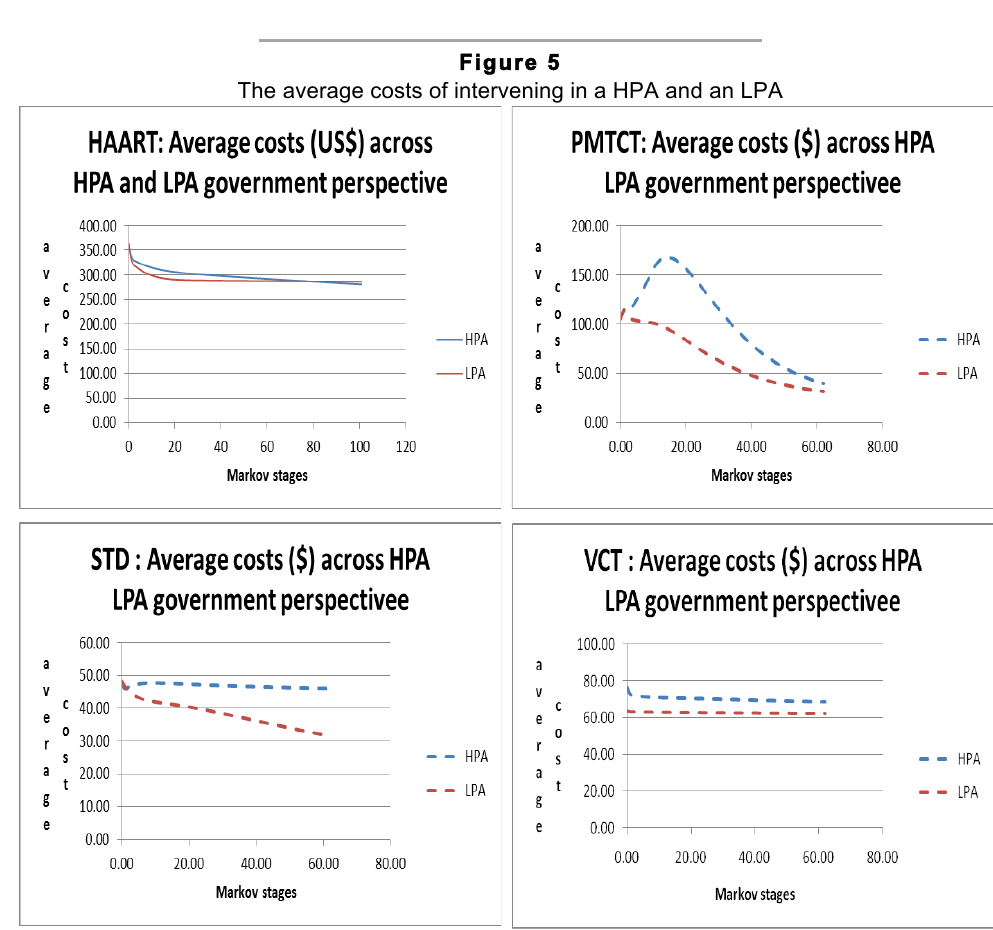
The average costs of intervening in a HPA and an